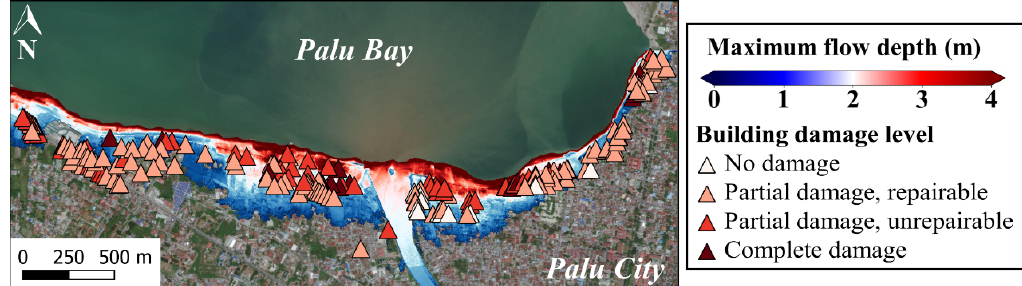
Figure 8. Sulawesi–Palu final tsunami inundation model with the maximum simulated flow depth overlaid on the damaged building data (background ESRI).